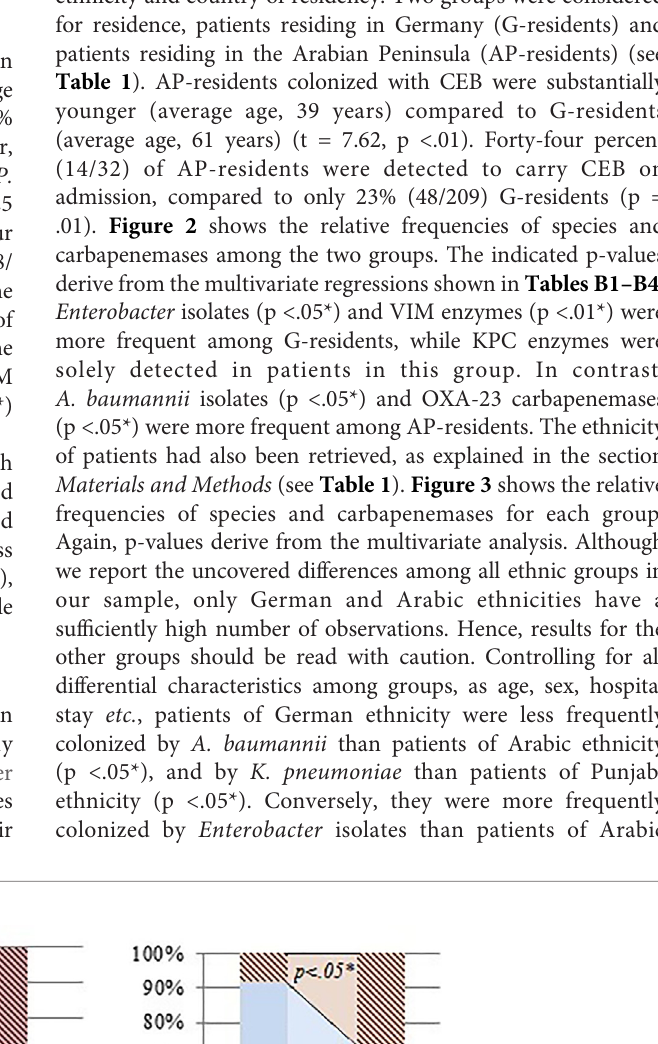
Frontiers in Cellular and Infection Microbiology |